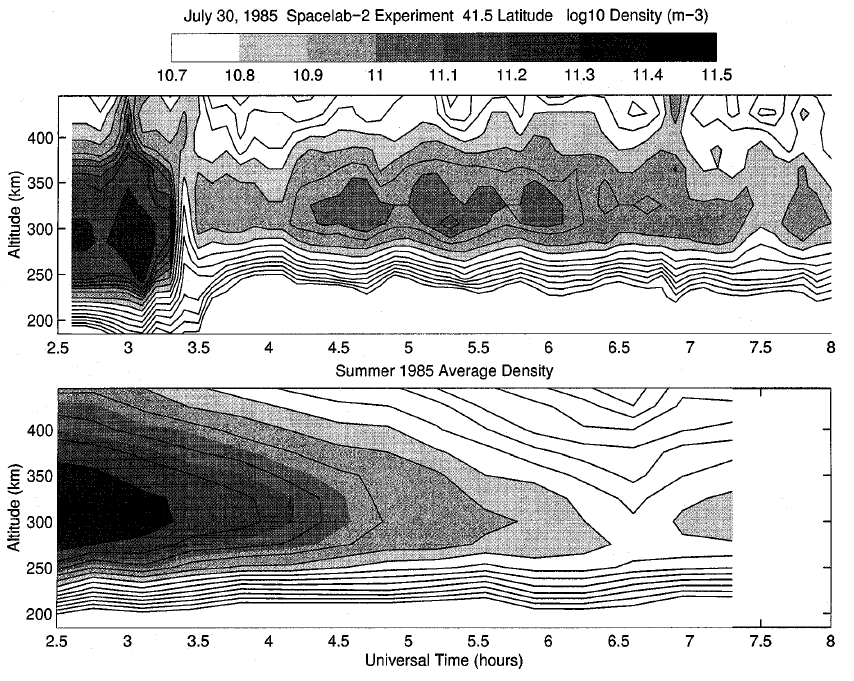
Fig. 1. Iso-density contours observed with the Millstone Hill radar in the 1.5 (cid:176) latitude swath centered at 41.25 (cid:176) latitude reveal the perturbation of the mid-latitude ionosphere associated with the Shuttle OMS burn. The lower panel presents the temporal evolution of the unperturbed ionosphere determined as the average of three radar experiments near 42.5 (cid:176) latitude. Significant depletion and oscillation of the bottomside F layer occurred during the July 30, 1985,